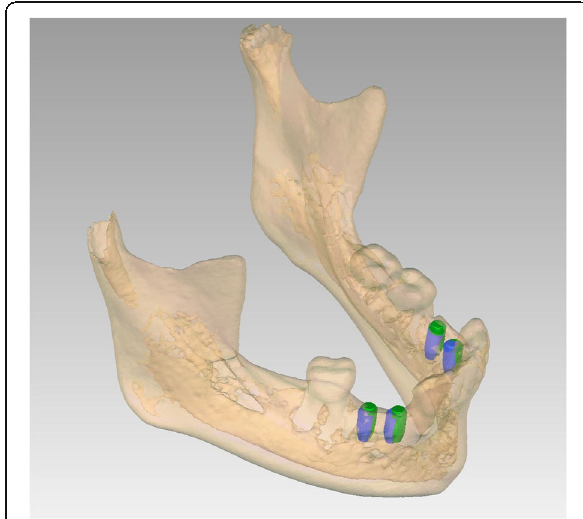
Fig. 10 Patient 1 — post-operative evaluation of placement accuracy of the implants in the mandible. Green is the planned position; blue is the actual